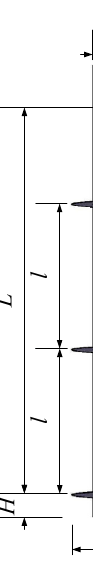
Figure 2. Schematic diagram of helical pile.